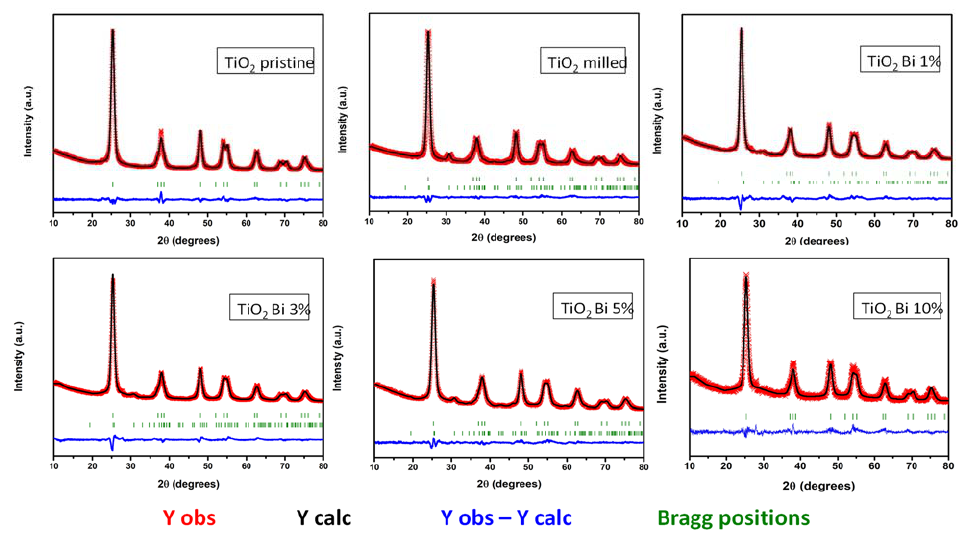
Figure 7. Observed (red line), calculated (black line), differences profiles (blue line), and Bragg positions (green) for the Rietveld refinement for the pristine TiO 2 , milled TiO 2 , and TiO 2 samples with different bismuth content. Table 2. Parameters of the anatase structure for the samples.